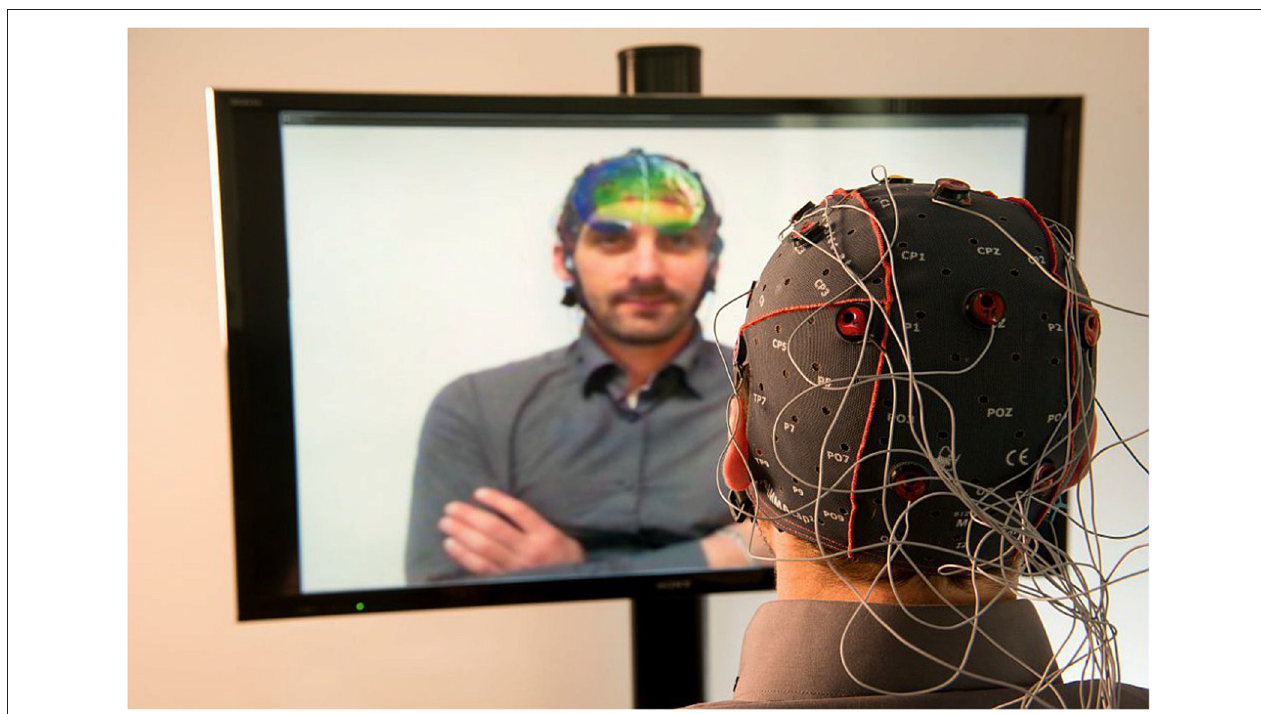
FIGURE 6 | The Mind–Mirror system: a virtual brain superimposed to the real user’s image (photomontage). Figure is reproduced with permission from the copyright holders.